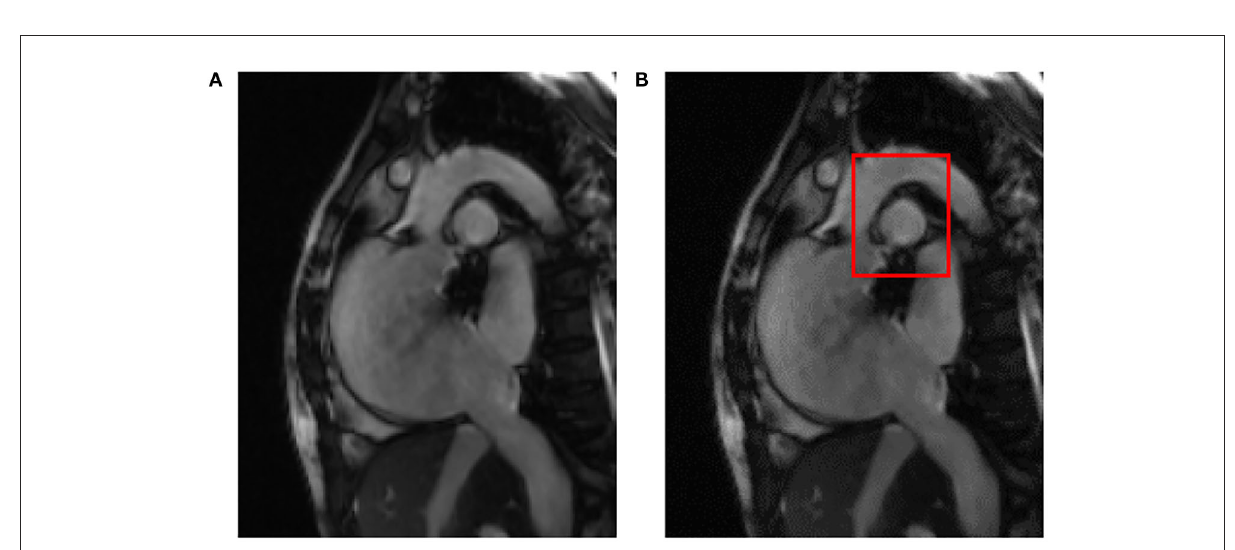
FIGURE3 ROI detection results based on (A) the original image and (B) the detected target